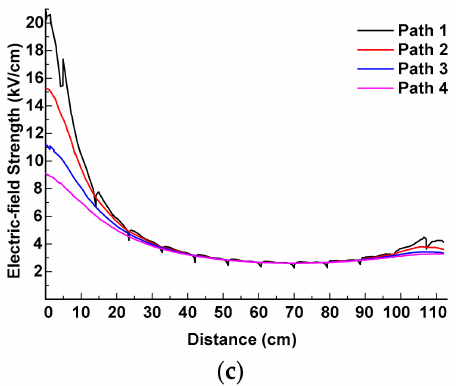
Figure 10. The electric field distribution of composite insulator in direction 1, 2, 3. ( a ) The electric field distribution in direction 1; ( b ) The electric field distribution in direction 2; ( c ) The electric field distribution in direction